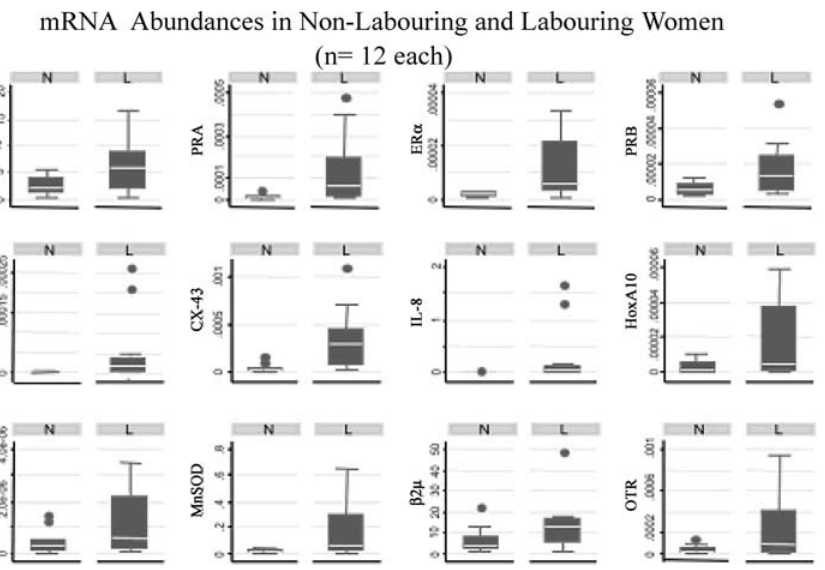
Figure 2. Messenger RNA Abundances in Human Myometrium Box and whisker plots of mRNA abundances of PRA and PRB, ER a , ER b , IL-8, COX-2, MnSOD, b 2-microglobulin ( b 2 l ), connexin-43 (CX-43), OTR, and the homeobox gene HoxA10 in labouring (L) and non-labouring (N) women. DOI: 10.1371/journal.pcbi.0010019.g002